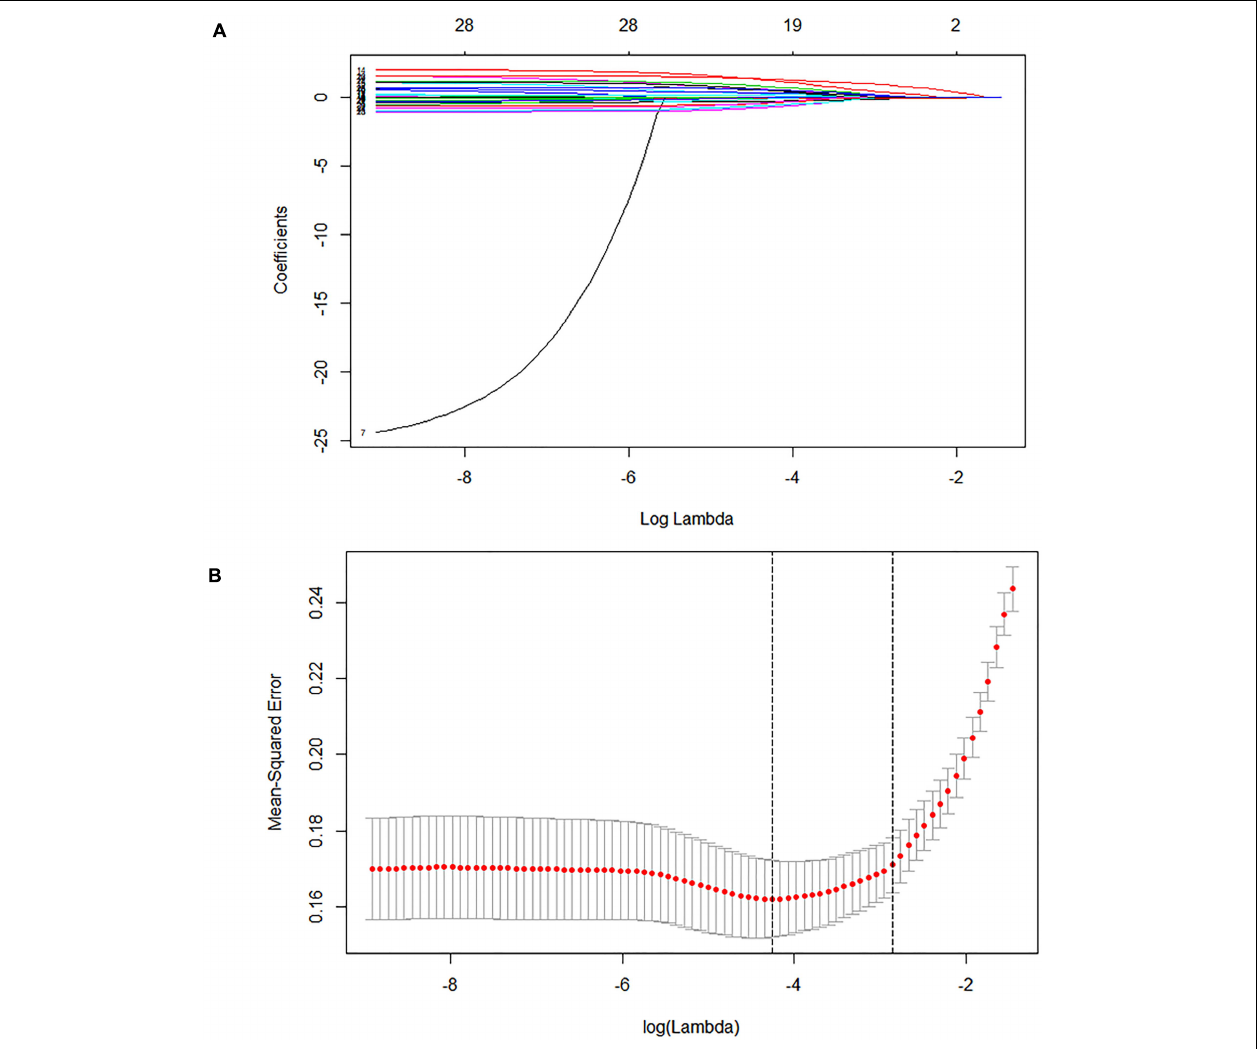
FIGURE 3 | Lasso feature selection diagram. The x -coordinate is the logarithm function of the penalty coefficient λ , and the y -coordinate is the mean square error. (A) As lambda changes, the coefficient of the variable is compressed to zero. (B) The dotted line on the left represents the value of the λ log function with the minimum mean squared error, and the right represents the best lambda log function. The value at the top of the image is the number of